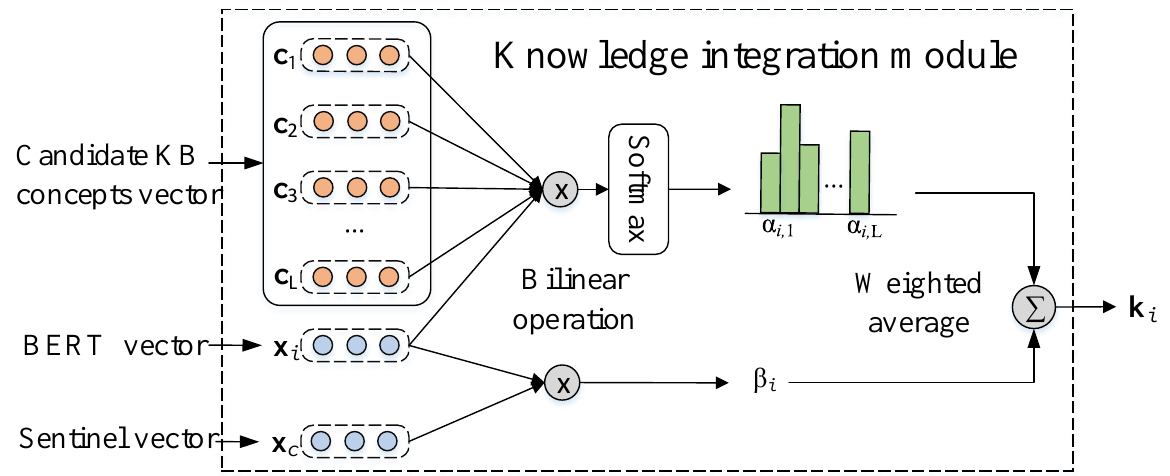
Figure 3. Detailed structure of the knowledge integration